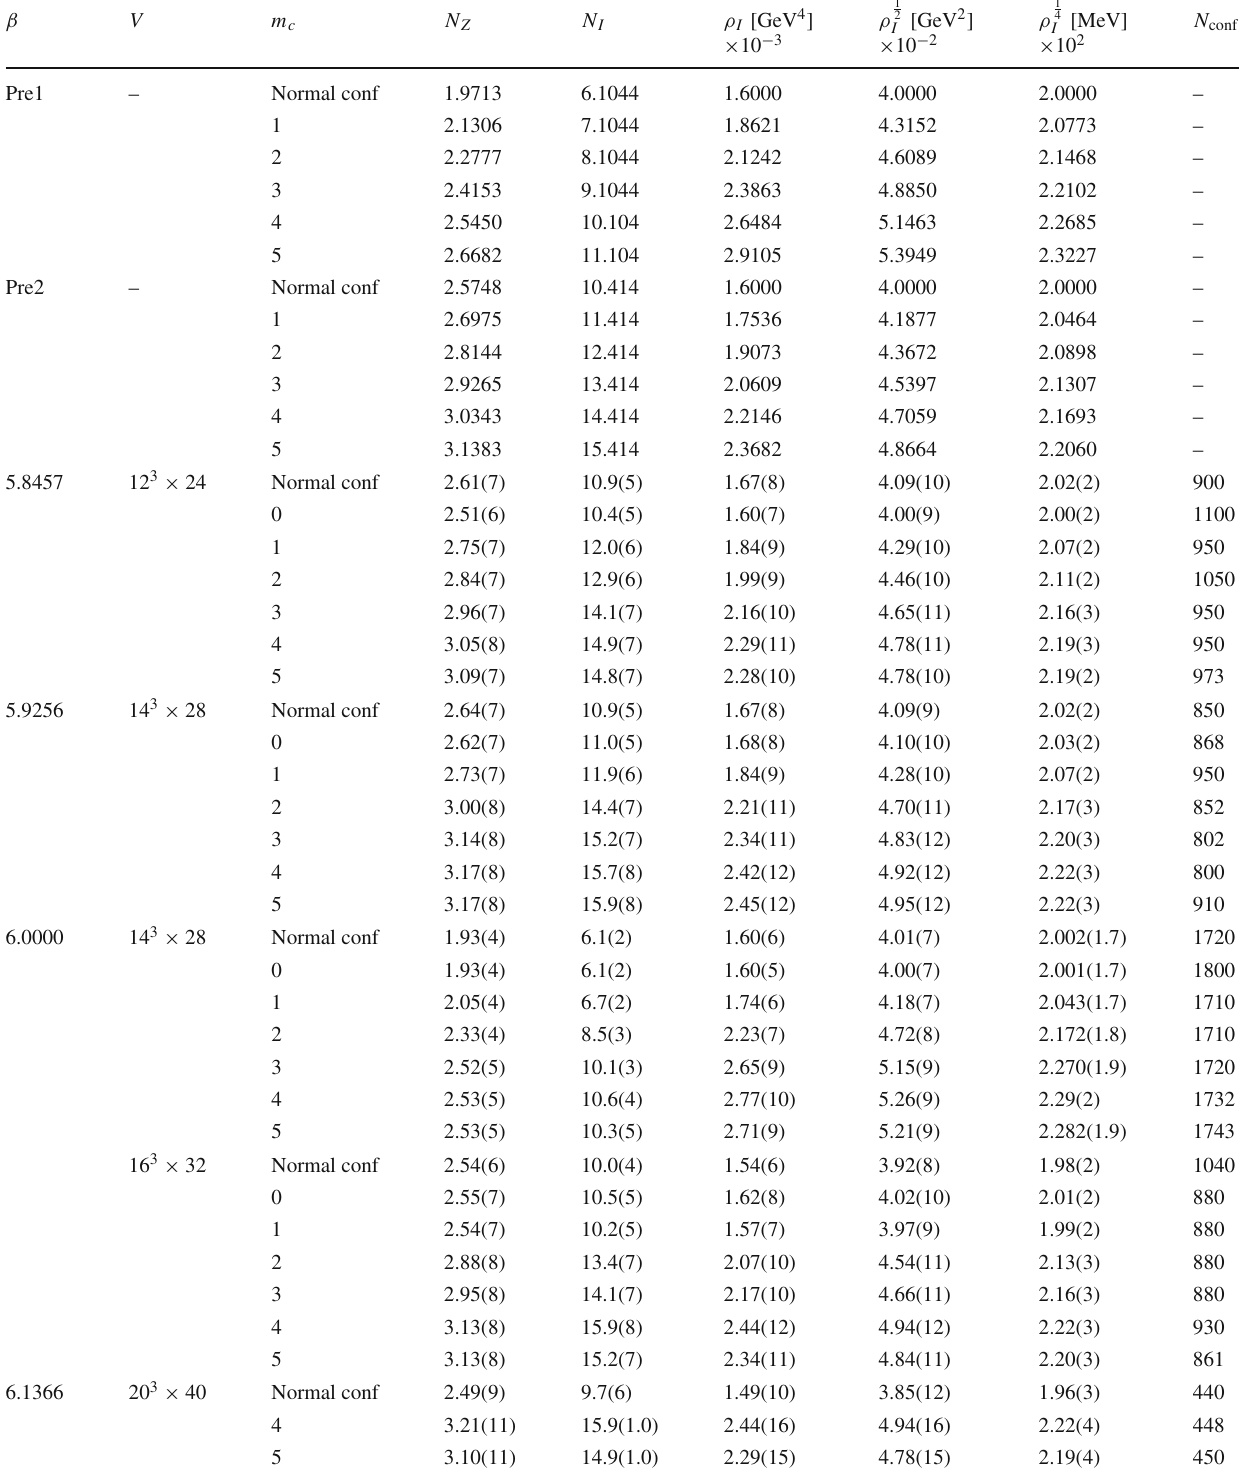
Table 29 The number of observed zero modes N Z = | Q | , number of instantons N I , and number density of instantons and anti-instantons ρ I , 1 ρ 1 2 4 , ρ , and their predictions. The predictions are indicated as Pre1 for I I thephysicalvolume V phys = 5 . 7845[fm 4 ]( β = 6 . 0000 , V = 14 3 × 28)